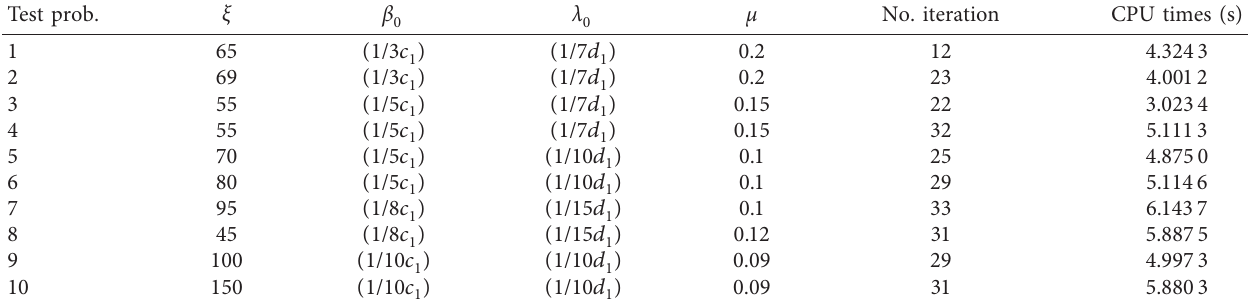
Table 2: Computed results for Algorithm 3.2 with the different parameters. Test prob.